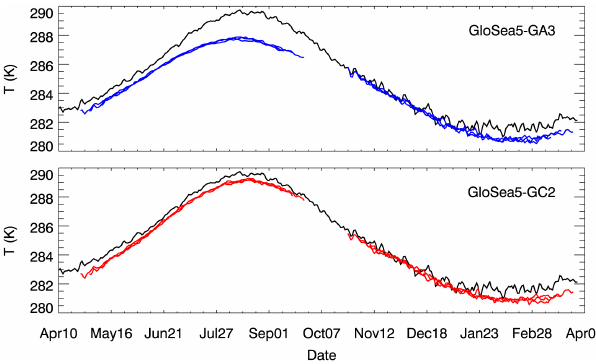
Figure 4. Mean 1.5m temperature over the North Atlantic (10– 50 ◦ W, 40–60 ◦ N) for the SEAS hindcasts (coloured). ERA-I is shown in